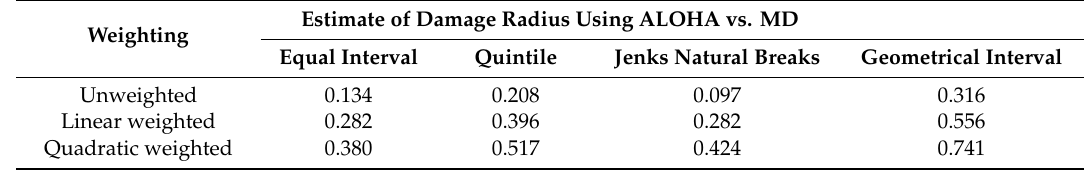
Table 7. Kappa statistics for classification methods and weighted methods.